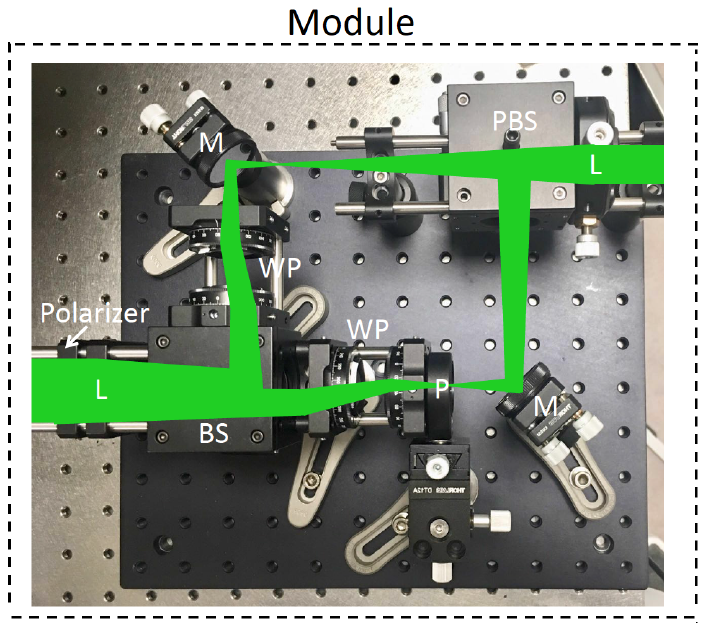
Figure 2. Image of the experimental setup for the off-axis DHM module proposed in this paper. L: Lens; P: Polarizer; BS: Beam-splitter; M: Mirror; WP: Wedge prism Pair. The system shown in the figure corresponds to the module shown within the dashed line in Figure 1 and is positioned at the side port of an I × 81